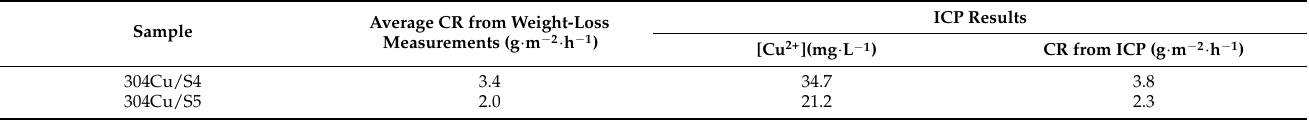
Table 3. Corrosion rates (CRs) from weight-loss measurements and ICP results.